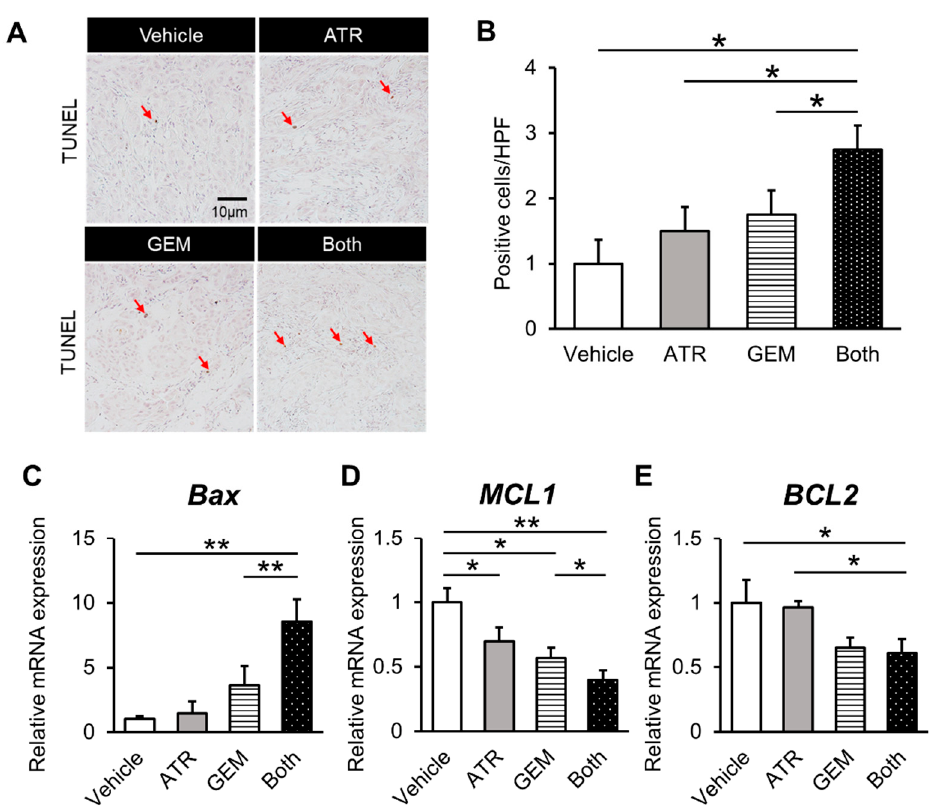
Figure 5. Gemcitabine plus atorvastatin promoted apoptosis in HuCCT-1 cell-derived xenograft tumors. ( A ) Representative pictures of HuCCT-1 cell-grafted subcutaneous tumors stained for TdT-mediated dUTP nick end labeling (TUNEL). Red arrows indicate immunopositive cells. ( B ) Quantification of TUNEL-positive cells. The number of immunopositive cells in high-power fields was counted. ( C – E ) The intratumor mRNA levels of BAX ( C ), MCL2 ( D ), and BCL2 ( E ). The mRNA expression levels were measured using quantitative real-time PCR, and glyceraldehyde-3-phosphate dehydrogenase was used as an internal control. Quantitative values are indicated as ratios relative to the values of the vehicle-treated group. ATR, atorvastatin-treated mice. GEM. gemcitabine-treated mice. Both, mice treated with both atorvastatin and gemcitabine. Data are presented as the mean ± SD ( n = 10). * p < 0.05; ** p < 0.01.